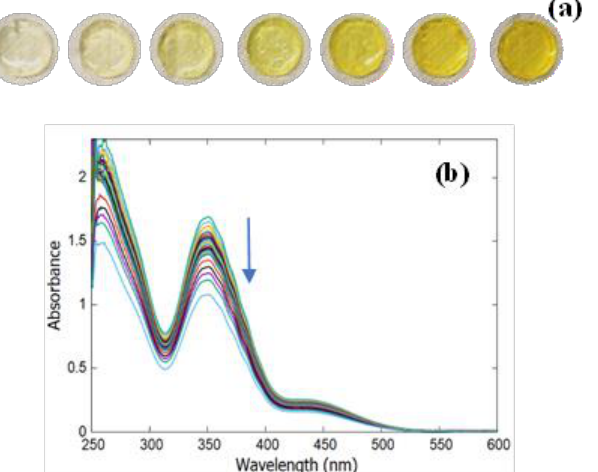
Figure 6. ( a ) Silica-based xerogel samples after absorption treatment by using different concentrations of Cr(VI) solutions from 36.53 to 269 mg/L, ( b ) UV-Vis spectra of Cr(VI) solution, with initial concentration of 55.41 mg/L, at different times during the absorption treatment with silica-based xerogel, the blue arrow represents the decrease in absorption during time.